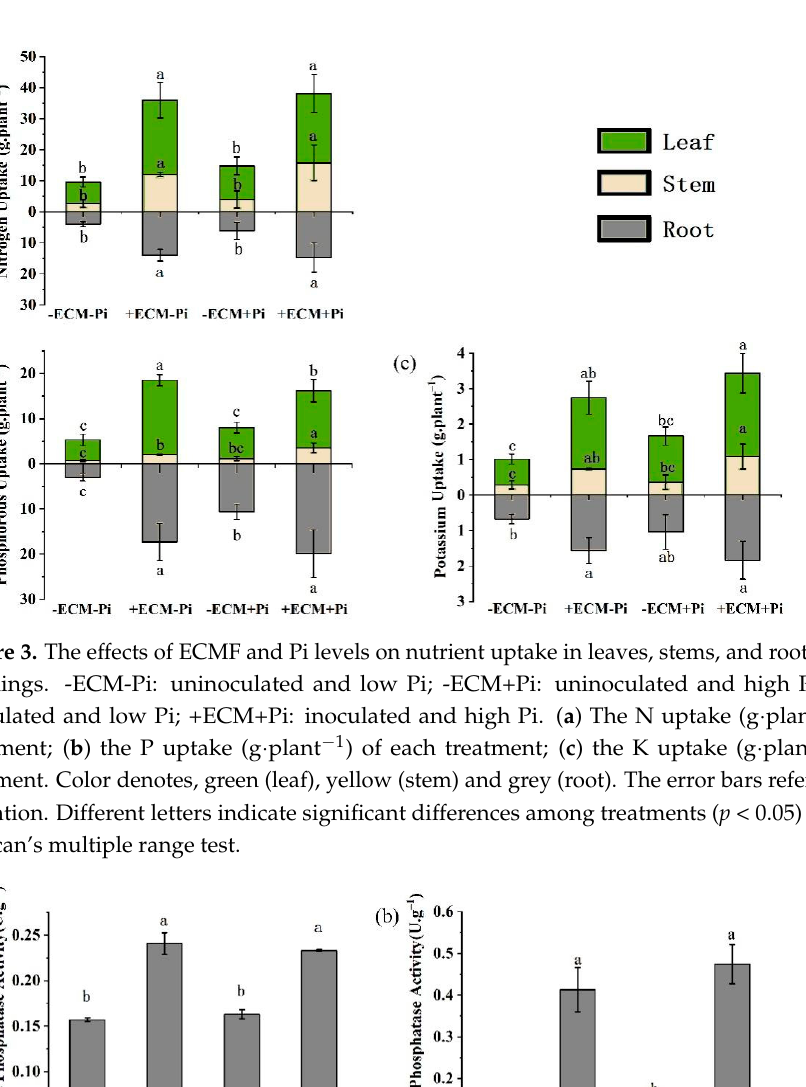
Table 2. Influence of ECMF and Pi levels on the chemical properties of the rhizosphere soil.